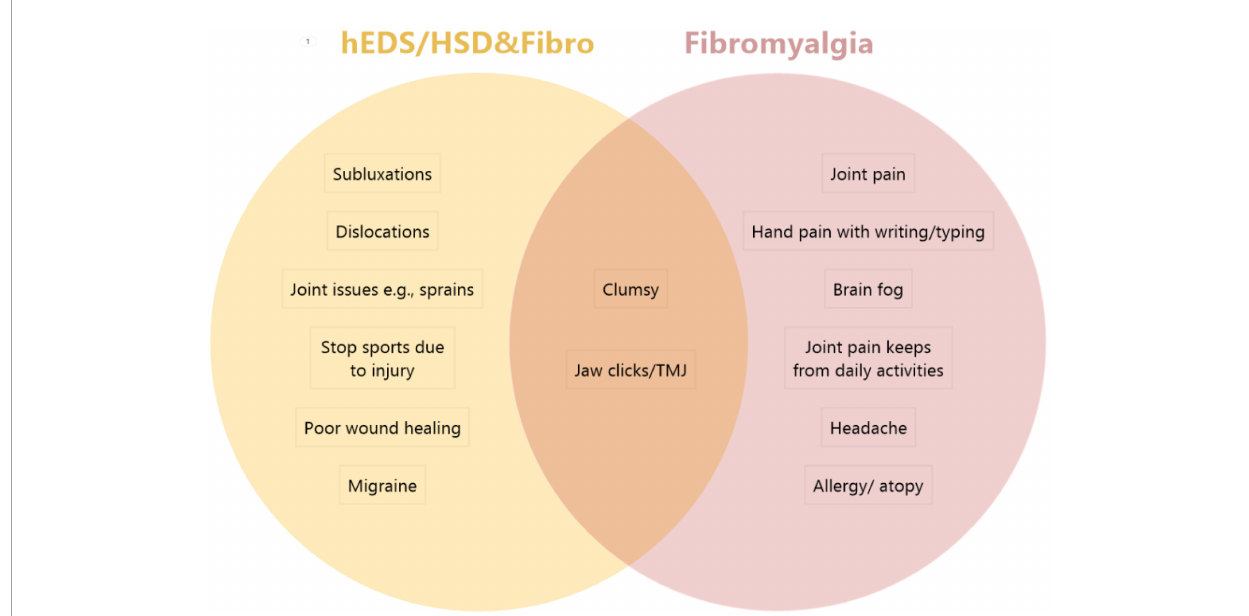
FIGURE1 Comparison of top symptoms/comorbidities in patients with hEDS/HSD&Fibro vs. Fibro. The top 5 issues that were significantly worse in hEDS/HSD and fibromyalgia patients (hEDS/HSD&Fibro) from Table 7 included (in order) subluxations, joint issues (e.g., sprains), stop sports due to injury, poor wound healing and migraine. The top issues in Fibromyalgia patients from Supplementary Table 3 in order included joint pain, hand pain with writing/typing, brain fog, joint pain keeps from daily activities, headache and allergy/atopy. Patients with hEDS&Fibro also reported dislocations as a top issue that was significantly different in Table 10 . Top issues in both patient groups included being clumsy and jaw clicks/TMJ.